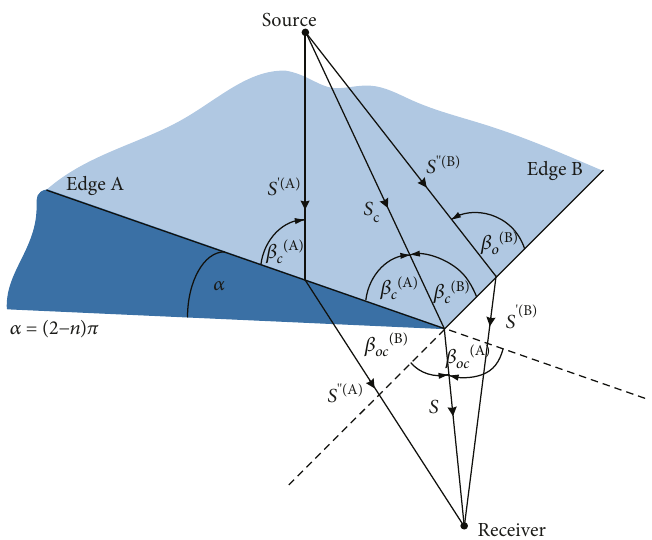
Figure 1: Geometry of PEC wedge con fi guration including edges and